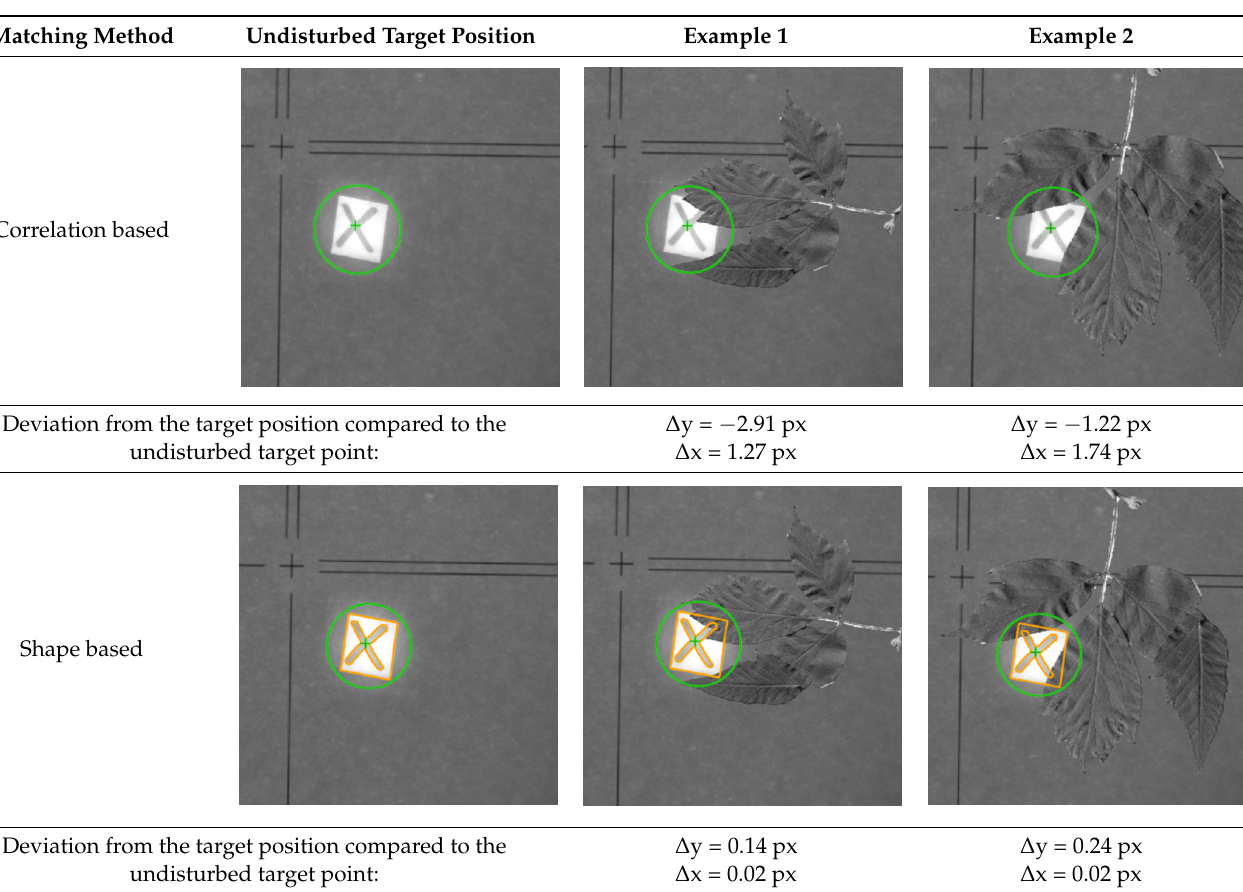
Table 2. Comparison of the results for correlation based and shaped based matching using the MoDiTa prototype and its software. The differences ( ∆ y, ∆ x) shown represent the change in pixel position relative to the template definition.